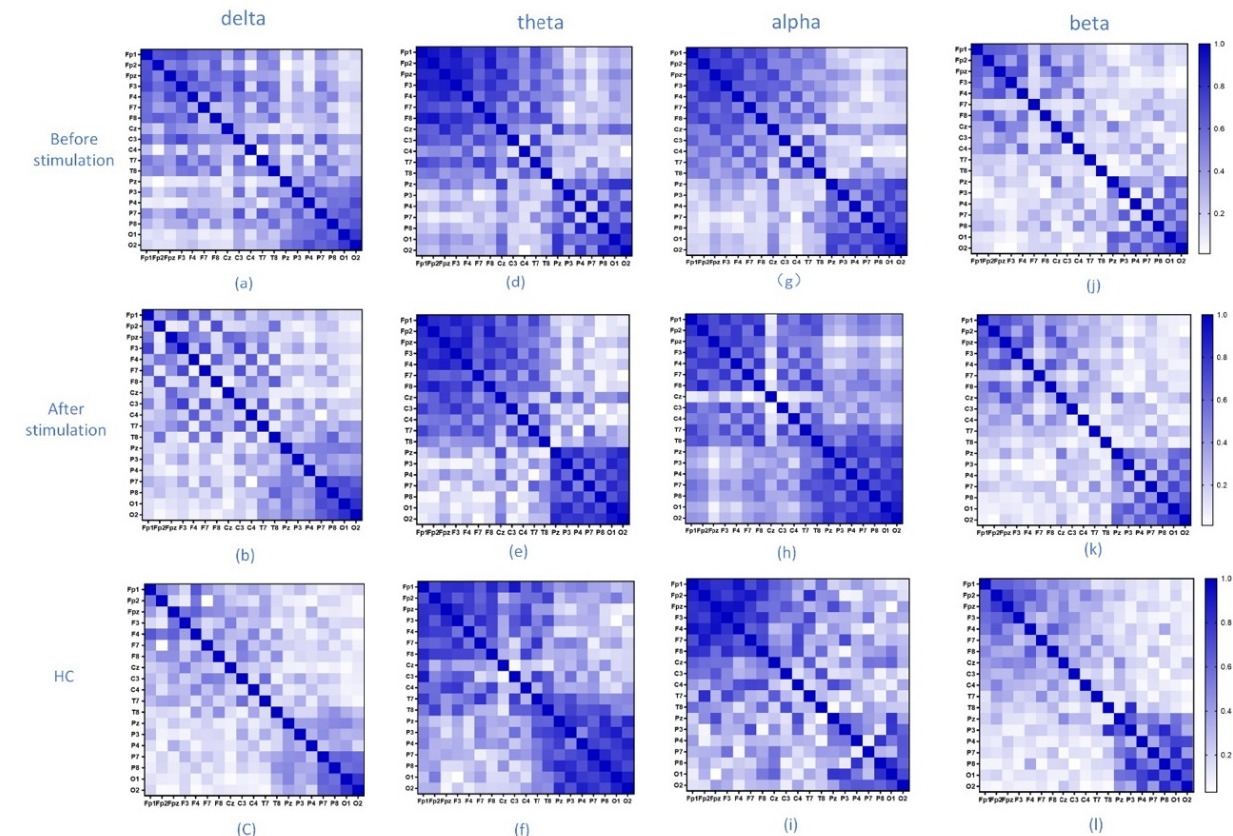
Figure 2. Before and after musical stimulation, depressed patients and healthy controls had different frequency band association matrices. Each row shows the state of the subject, and each column shows the frequency band of the signal ( a – l